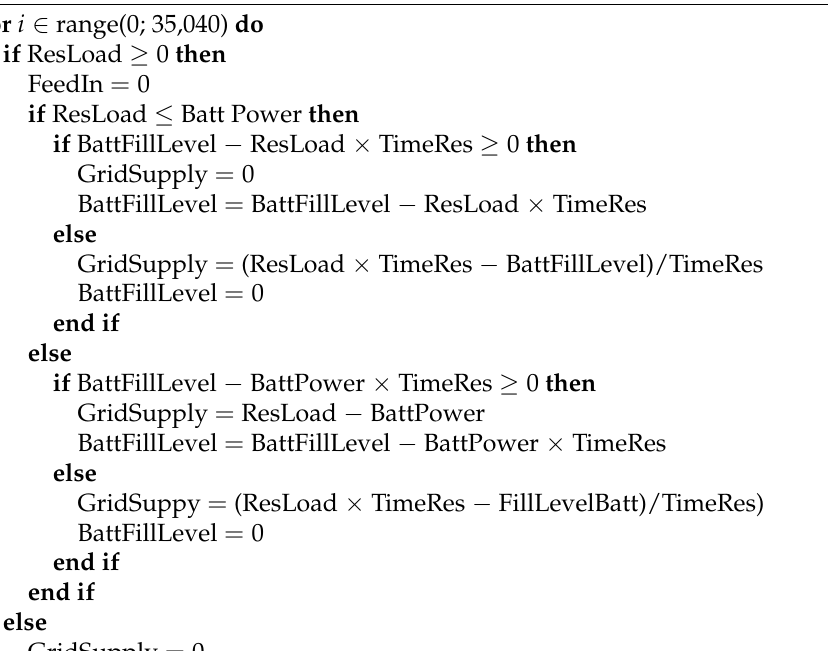
Algorithm A1. Battery operation mode